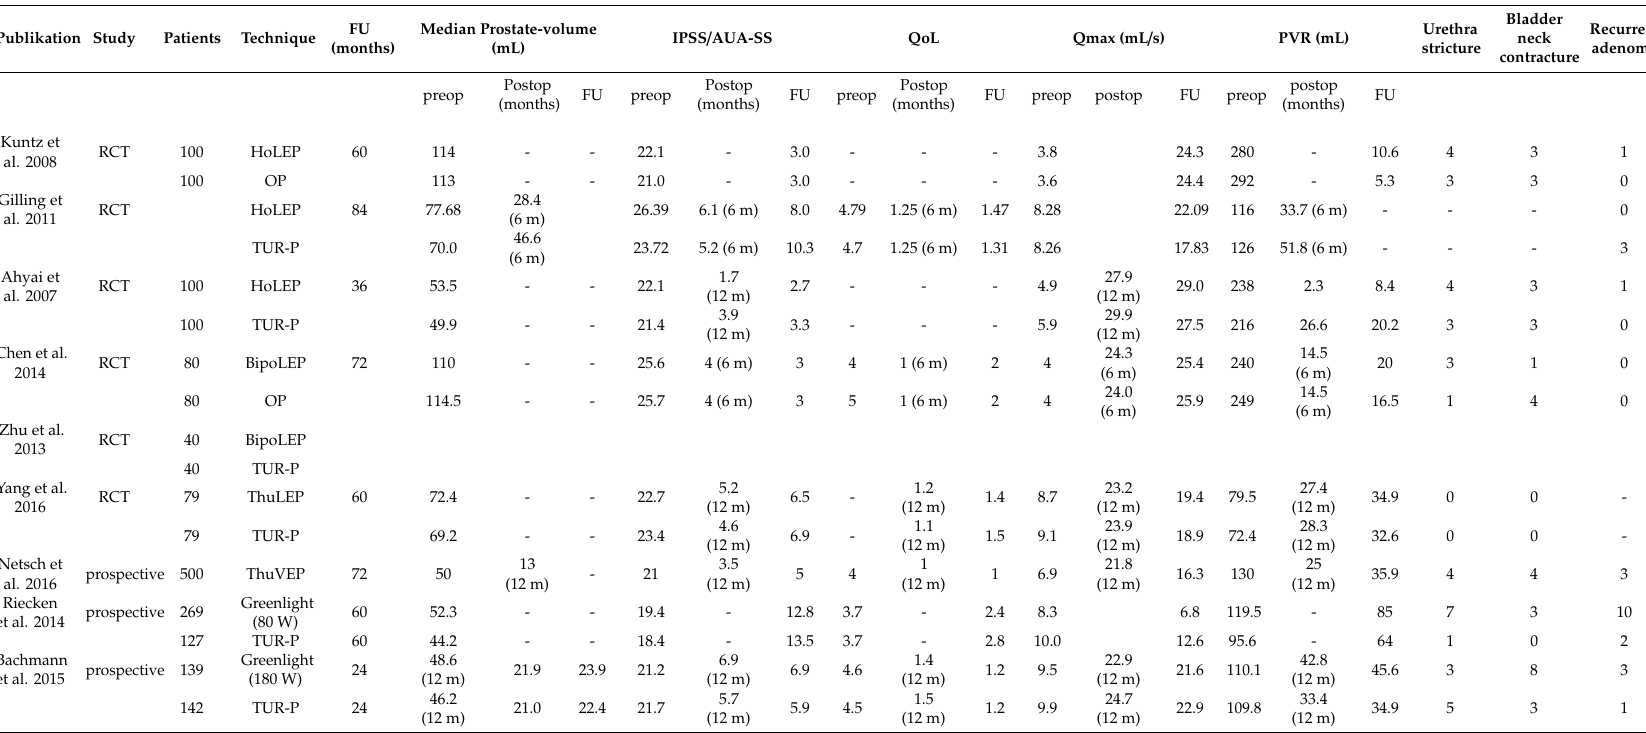
Table 2. Long-term functional outcomes of BPH treatments. (HoLEP = Holmium Laser Enucleation of the Prostate, ThuVEP = Thulium Vapoenucleation of the prostate, ThuLEP = Thulium Enucleaion of the prostate, TmLPR − TT = Thulium laser resection of the prostate-tangerine technique, DiLEP = Diode Laser Enucleation of the